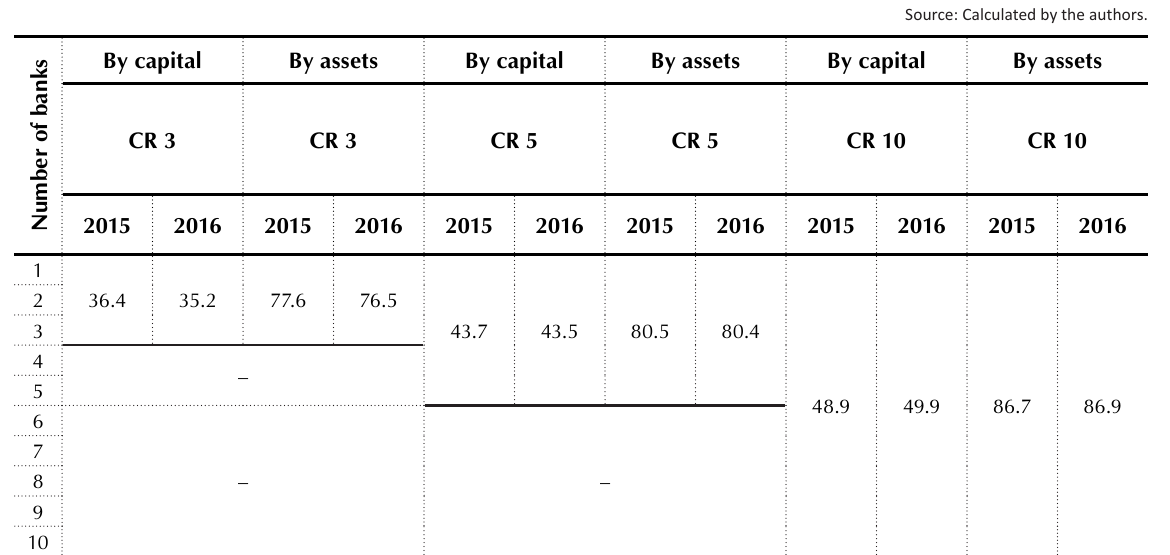
Table 2. L evel of concentration of the banking services market of Ukraine with different number of banking institutions for 2015 –